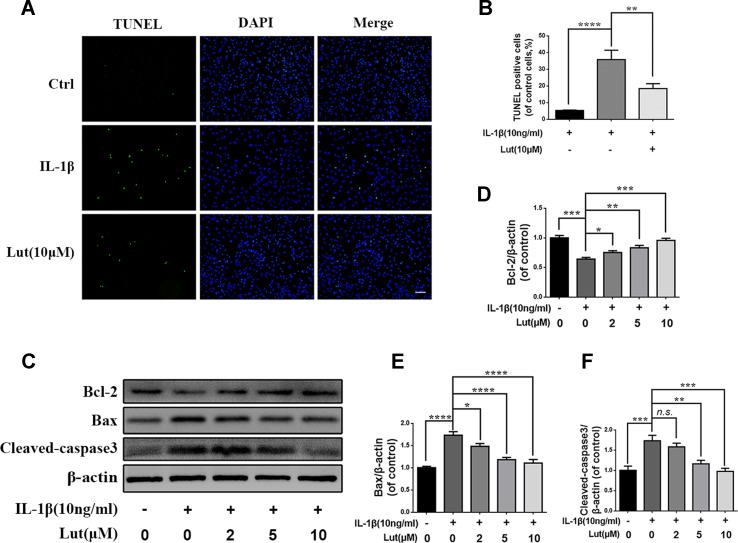
Luteoloside inhibit IL-1β induced apoptosis in nucleus pulposus cells. NP cells treated with various concentration of luteoloside for 24 h within IL-1β stimulation. (A) Apoptosis cells were measured in nucleus pulposus cells by terminal deoxynucleotidyl transferase dUTP nick end labeling (TUNEL) Kit (original magnification × 200, scale bar: 50 µm). (B) Three images were randomly selected, and the number of cells with green fluorescence was quantified. (C) The protein expression of cleaved-caspase 3, Bax, and Bcl-2 evaluated by western blot in nucleus pulposus cells. (D–F) Quantification of immunoblots of cleaved-caspase 3, Bax, and Bcl-2, and each band was normalized to each individual sample’s housekeeping gene. The experiment was repeated three times, with a representative example shown. All experiments were performed at least three times, and the data in the figures represent the mean ± S.D. Significant differences between groups are indicated as ****P < 0.0001, ***P < 0.001, **P < 0.01, *P < 0.05.